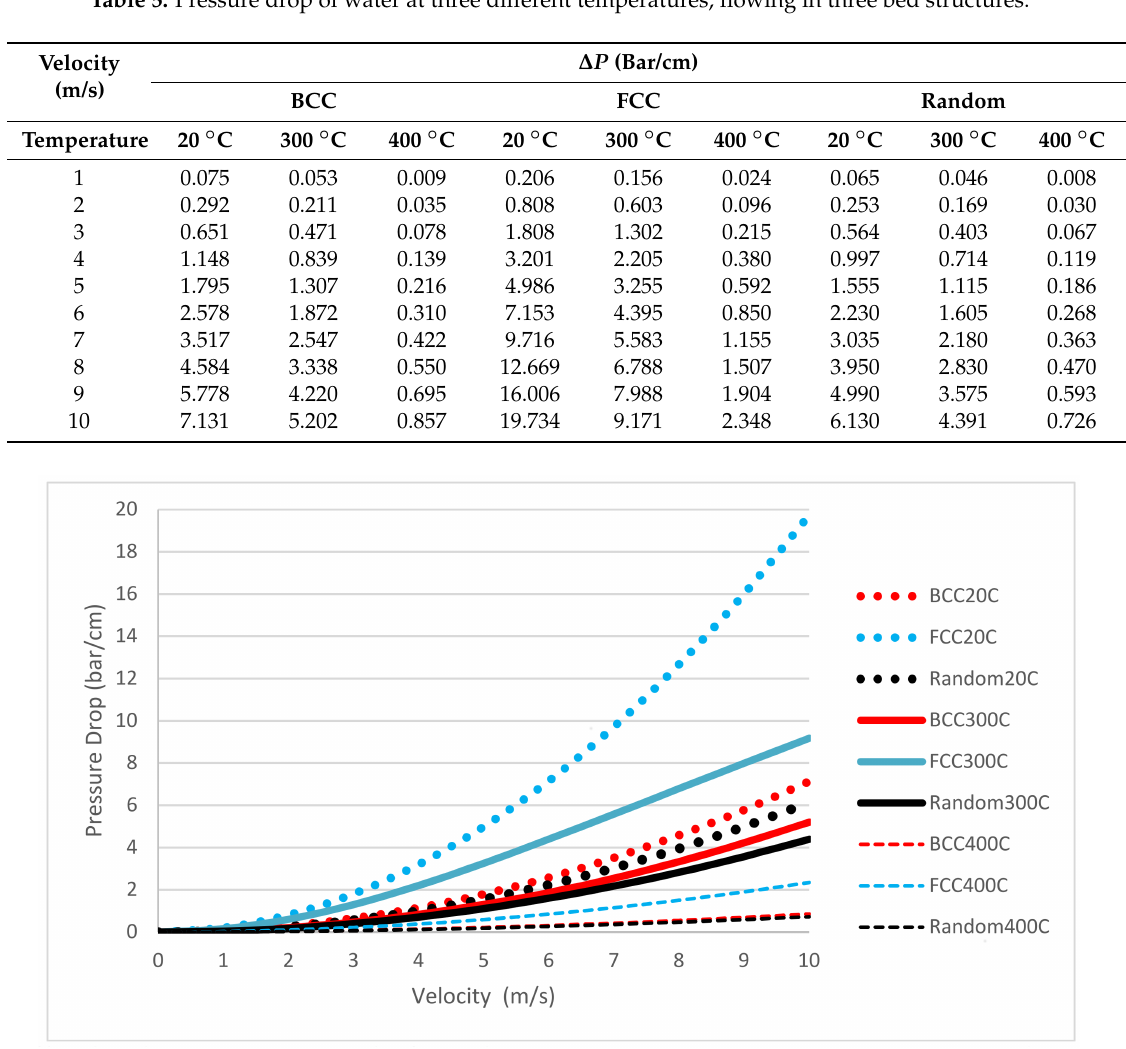
Figure 17. Pressure drop as a function of velocity at three bed structures and fluid temperatures with 15 mm spheres.